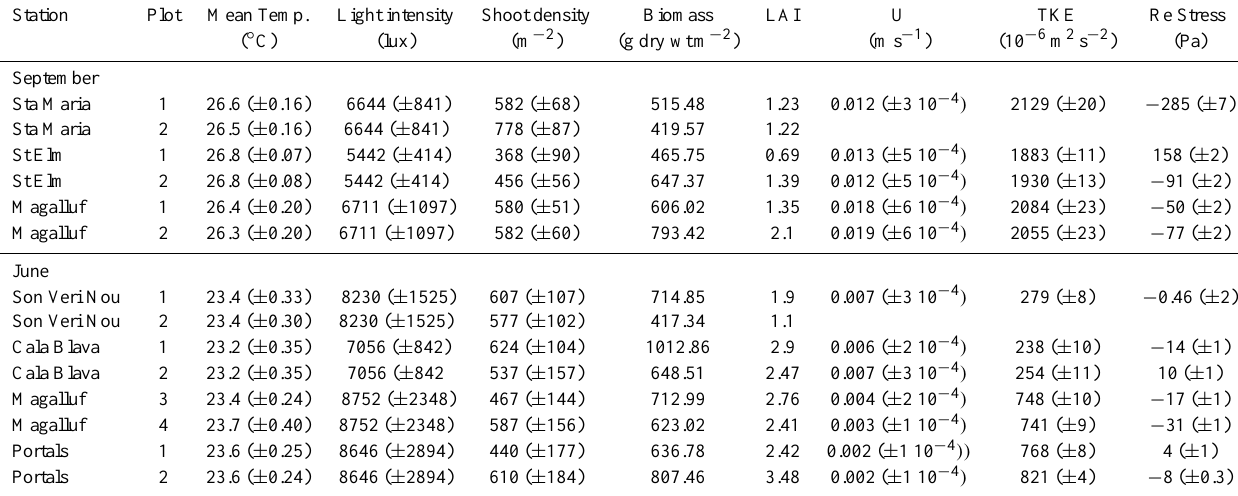
Table 1. Mean ( ± SD) environmental parameters (temperature in ◦ C, light intensity in lux), hydrodynamics ( ± SE) and characteristics of the seagrass meadows (shoot density ( ± SE), biomass, LAI) at the sites sampled in this study. Station Plot Mean